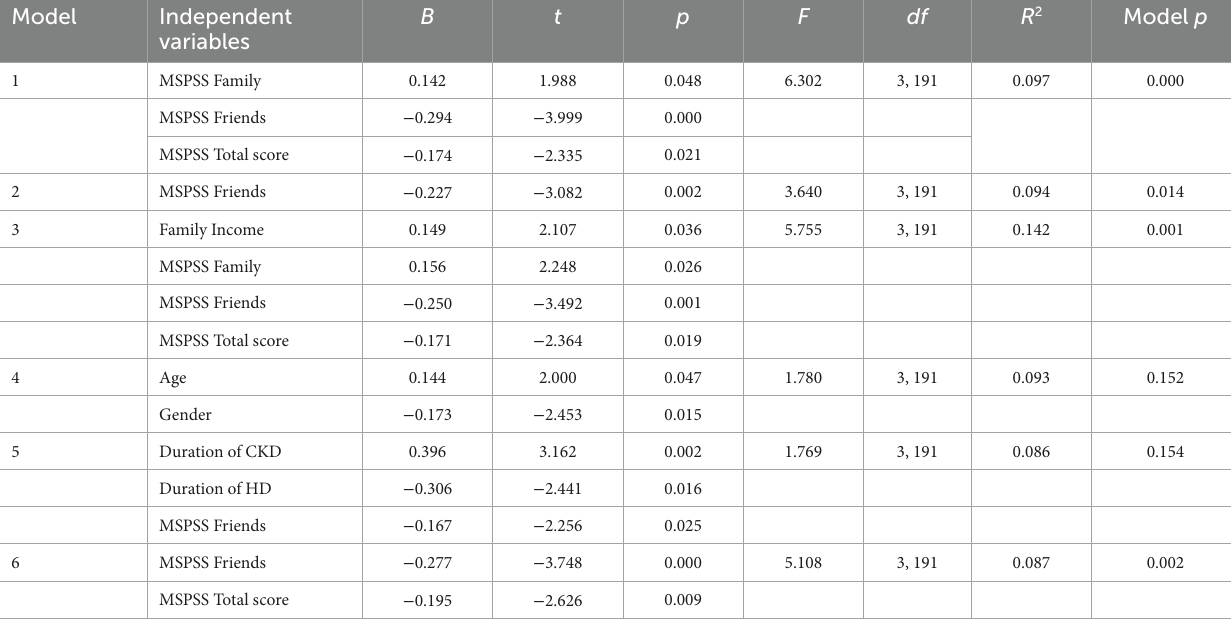
TABLE 4B Hierarchical regression analyses of PSQI dimensions.